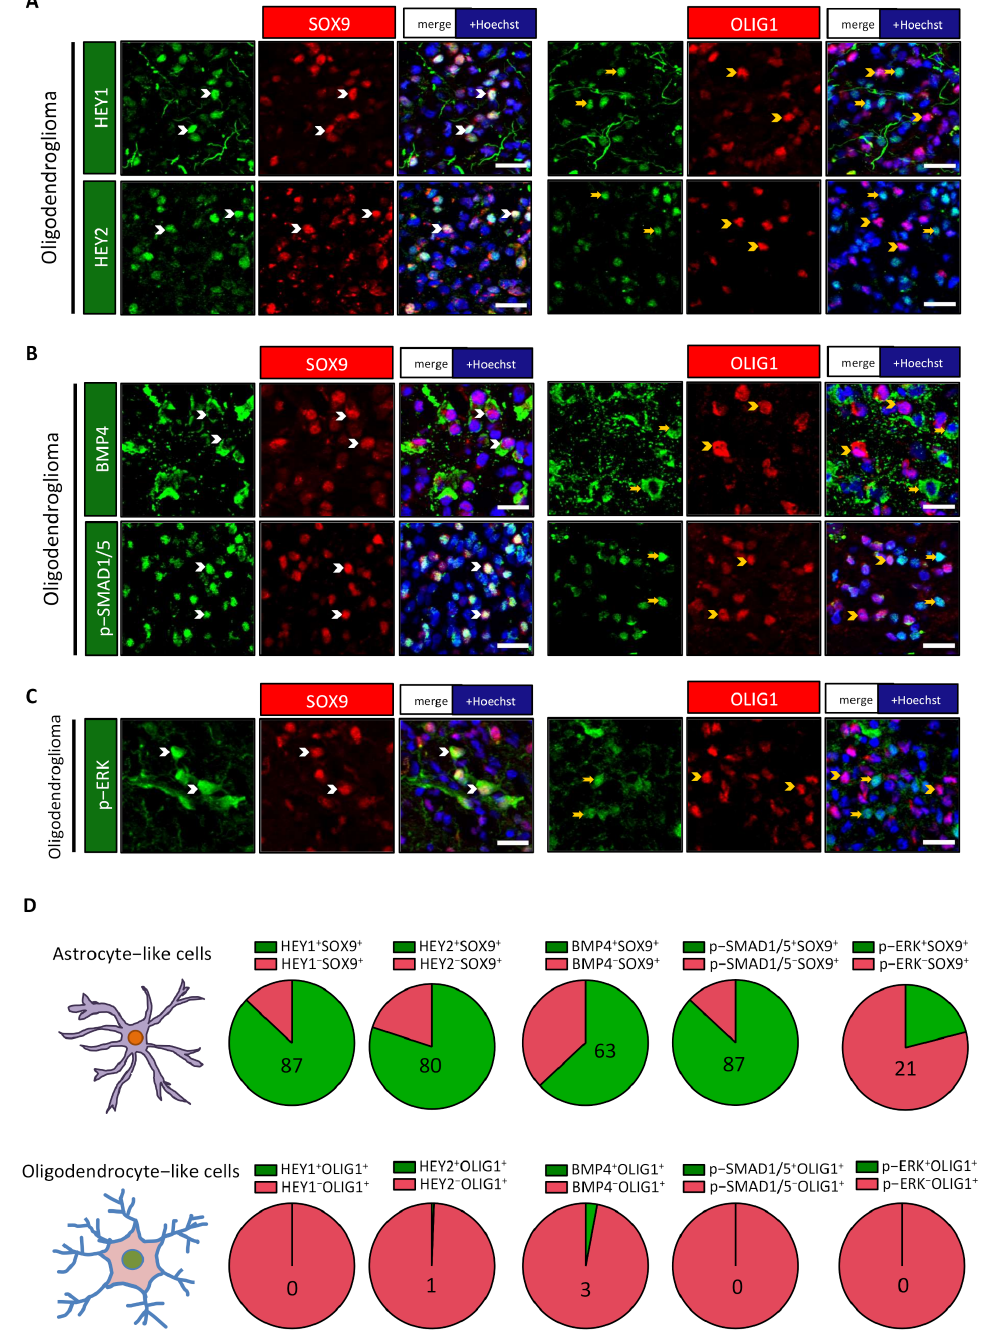
Figure 3. SOX9 + cells express specific signalling proteins and transcription factors. ( A – C ) Double immunofluorescences in one oligodendroglioma for HEY1, HEY2, BMP4, p-SMAD1/5, and p-ERK with SOX9 and OLIG1 revealed their preferential expression in SOX9 + cells. White arrowheads identify double-positive cells, while yellow arrowheads/arrows show single-positive cells. Scale bars = 20 µ m. ( D ) Pie diagrams representing the percentage of double-positive (green) and single-positive (red) cells in SOX9 + and OLIG1 + cells. Numbers indicate the percentage of double-positive